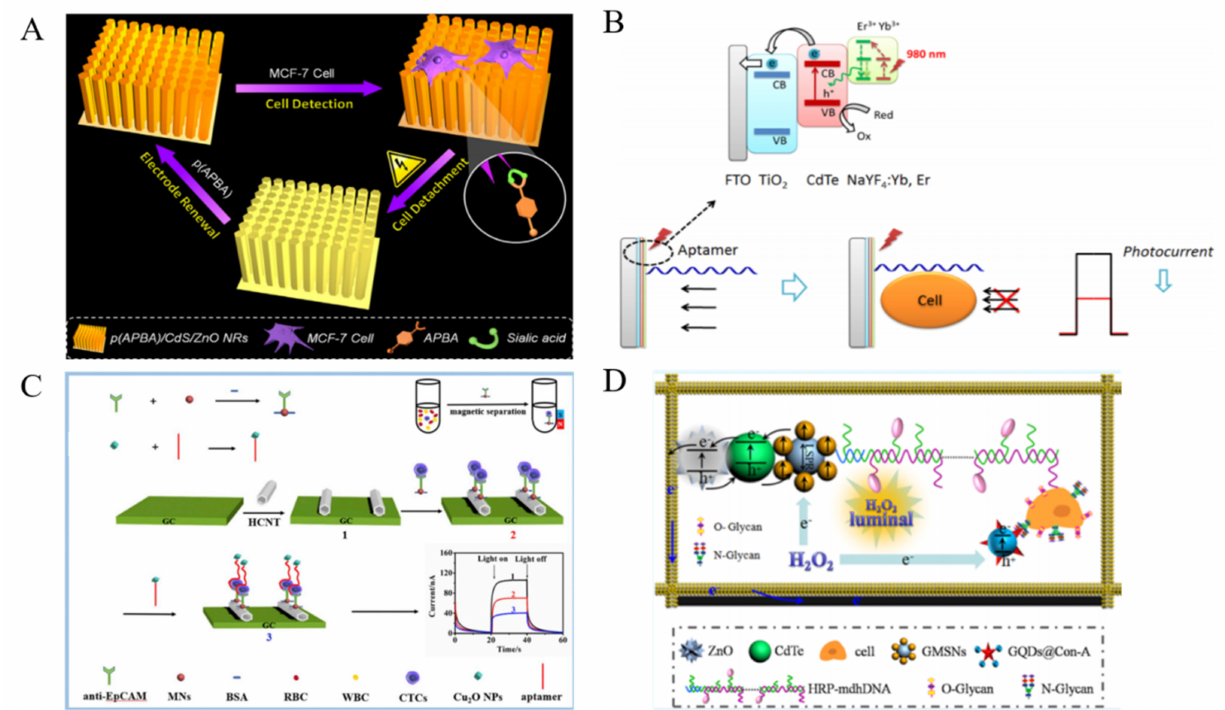
Figure 17. ( A ) Schematic representation of renewable PEC cytosensor for CTC capture and refresh [264]. Copyright 2021 Elsevier B.V. ( B ) Schematic representation of the NIR-light-excited PEC interface and the MCF-7 cell detection principle [267]. Copyright 2016 American Chemical Society. ( C ) Schematic representation of CTC measurement in whole blood based on